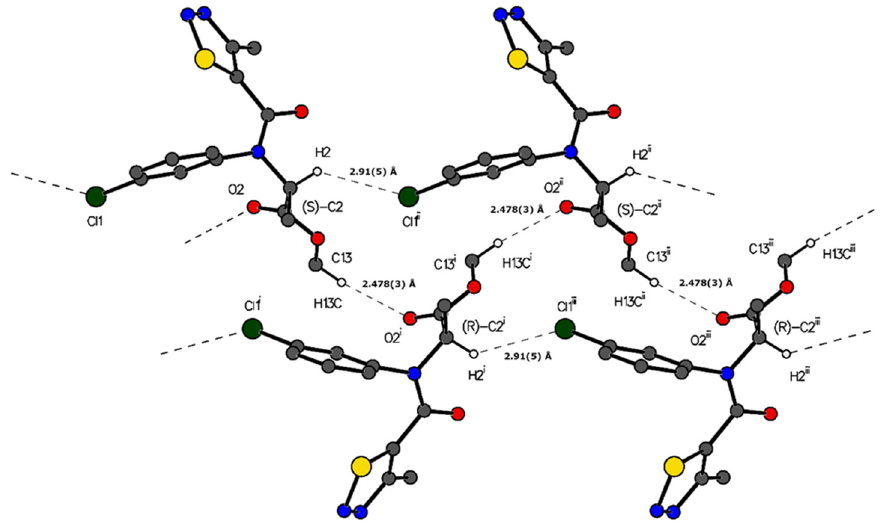
Figure 2. Part of the crystal lattice of compound 1f , showing the formation of a double chain along the a -axis with C(2)H(2) ... Cl(1) and C(13)H(13C) ... O(2) bonds. For clarity, only those hydrogen atoms which are engaged in the intermolecular interactions are indicated. Symmetry codes: (i) 1/2 + x, +y, 3/2 − z (ii) 1 + x, 2 + y, +z (iii) 3/2 + x, +y, 3/2 − z.